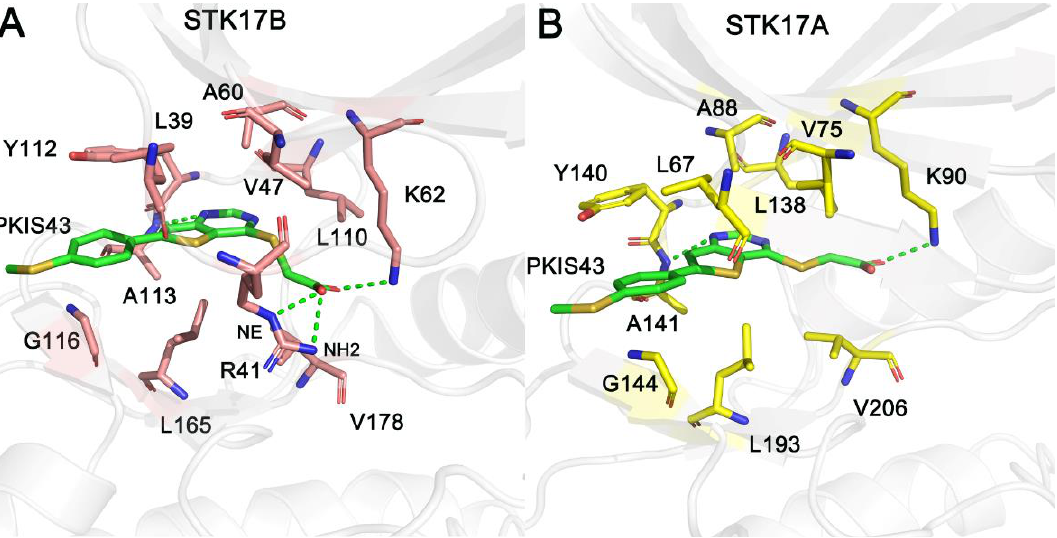
Figure 6. The detailed interaction modes of STK17B – PKIS43 ( A ) and STK17A – PKIS43 ( B ) complexes. The atoms named “NE” and “NH2” of Arg41 in STK17B are labeled. Hydrogen bonds or salt bridges are shown by green dotted lines.